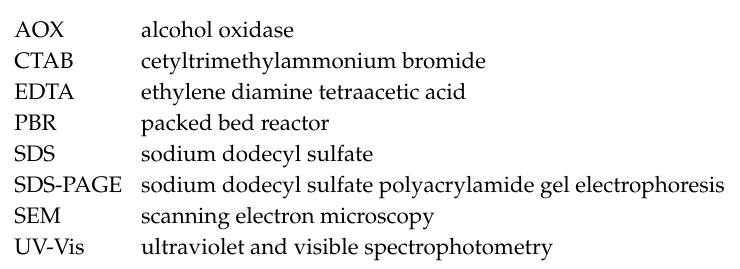
Figure S1: Transformation and screening of recombinant P. pastoris. Figure S2: Expression and SDS-PAGE analysis of Est M160K in E. coli and Pichia pastoris. Figure S3: SEM of the surface of epoxy resin lx-105s before and after immobilization of Est M160K . Figure S4: Degradation of malathion by immobilized lx-Est M160K and packed-bed bioreactor for biodegradation of bifenthrin. Figure S5: The standard curve of malathion. Figure S6: Detection wavelength of bifenthrin, physical picture of degradation reactor and HPLC detection results. Table S1: Substrate specificity of lx-Est M160K . Table S2: Sequences of primers used in this study. Table S3: Experimental results of accuracy of bifenthrin analysis